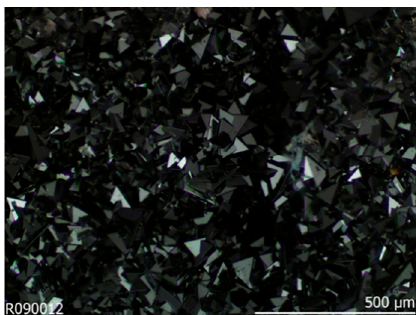
Figure 1. Image of Brunogeierite crystals from Tsumeb, Namibia, taken from RRuff Database [2].